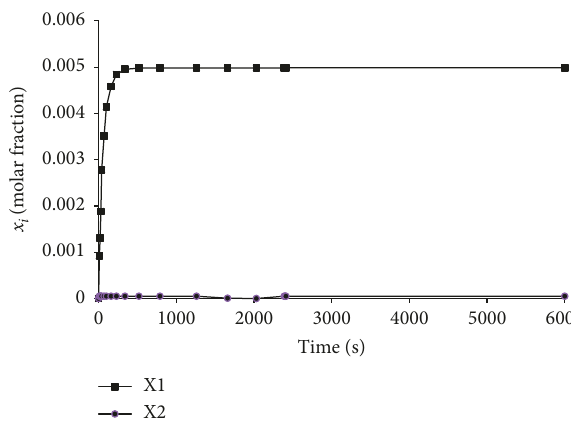
Figure 13: Time evolution of the volumetric H/Pd ratios on both sides of the membrane.